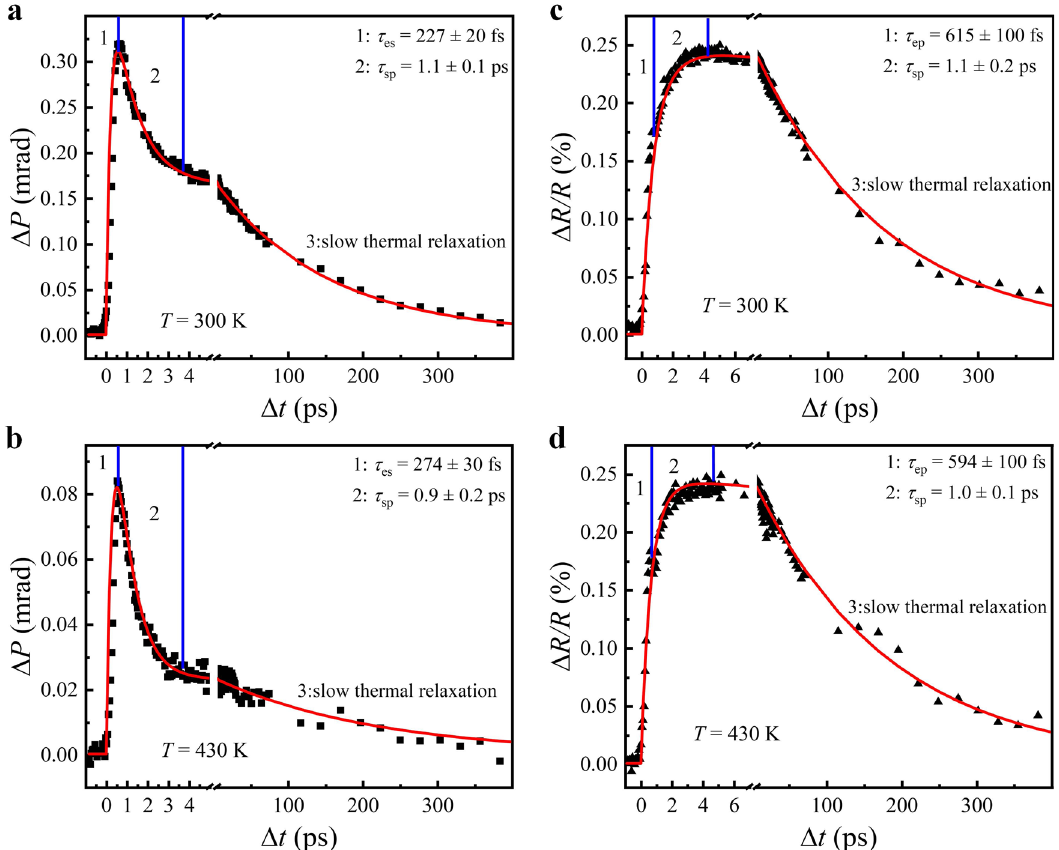
Fig. 5 Simualtion of pump-induced demagnetization and re fl ection. Dynamic Δ P signals at 300 K ( a ) and 430 K ( b ), and dynamic Δ R signals at 300 K ( c ) and 430 K ( d ). The solid curves correspond to the fi tting results. τ es , τ ep , and τ sp represent the energy transfer time in electronic-spin, electronic-lattice and spin-lattice system,